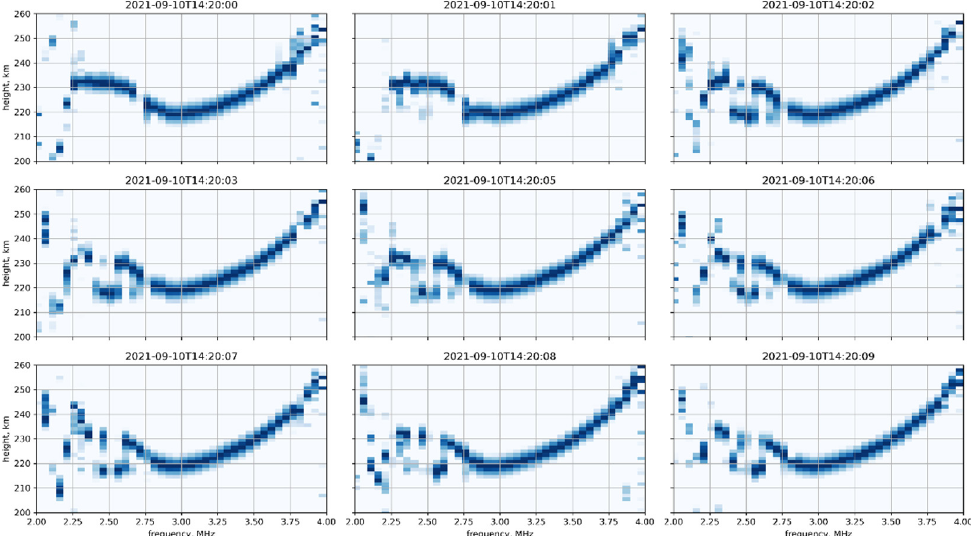
Figure 6. ( Left panel ): an example of an ionogram recorded with the developed ionosonde prototype using a diagnostic antenna (O mode output). Red square corresponds to the ionograms’s subarray which presented in detail in Figure 8. ( Right panel ): an example of an ionogram registered with a CADI ionosonde. Ionogram’s registration times are shown in UTC at the top of the panels.